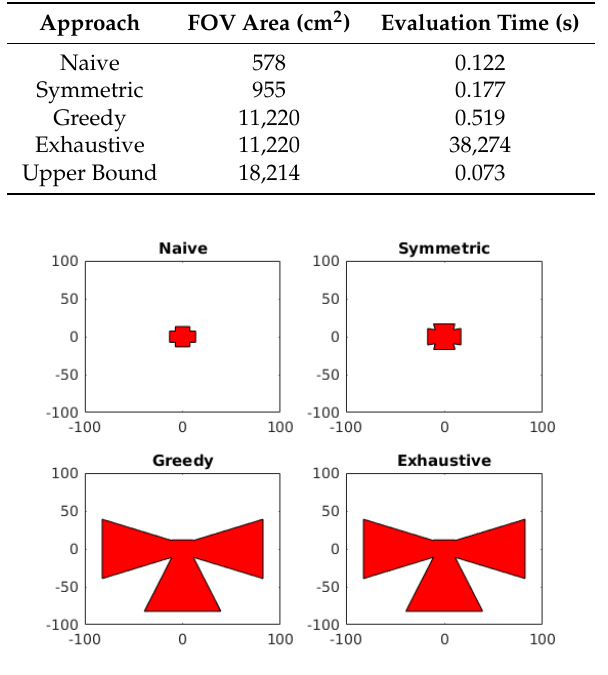
Table 1. Results of Maximal Area Optimization Methods on Surgical Array.